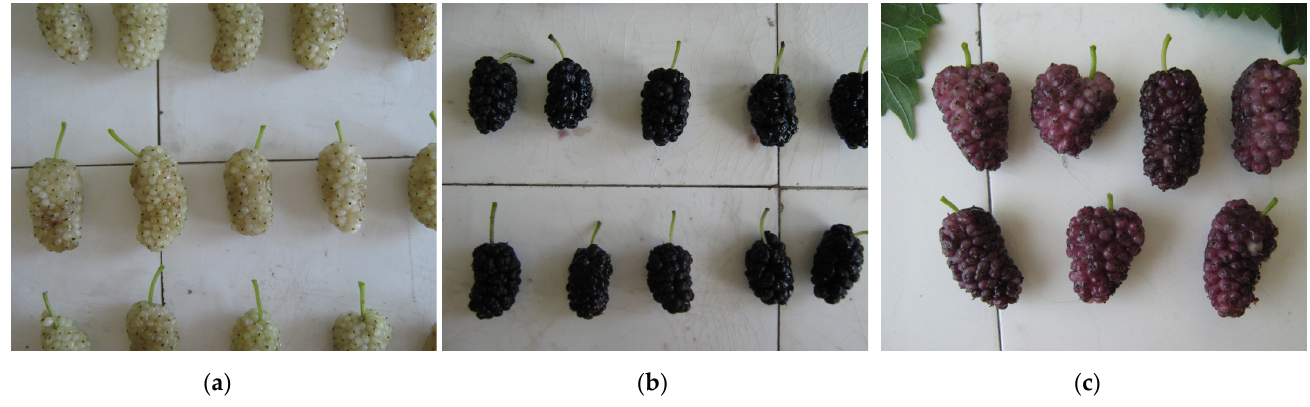
Figure 2. Fruit (berry) appearance of white mulberry—DJ1 ( a ), black mulberry—ZP3 ( b ) and red mulberry—MR1 ( c ).